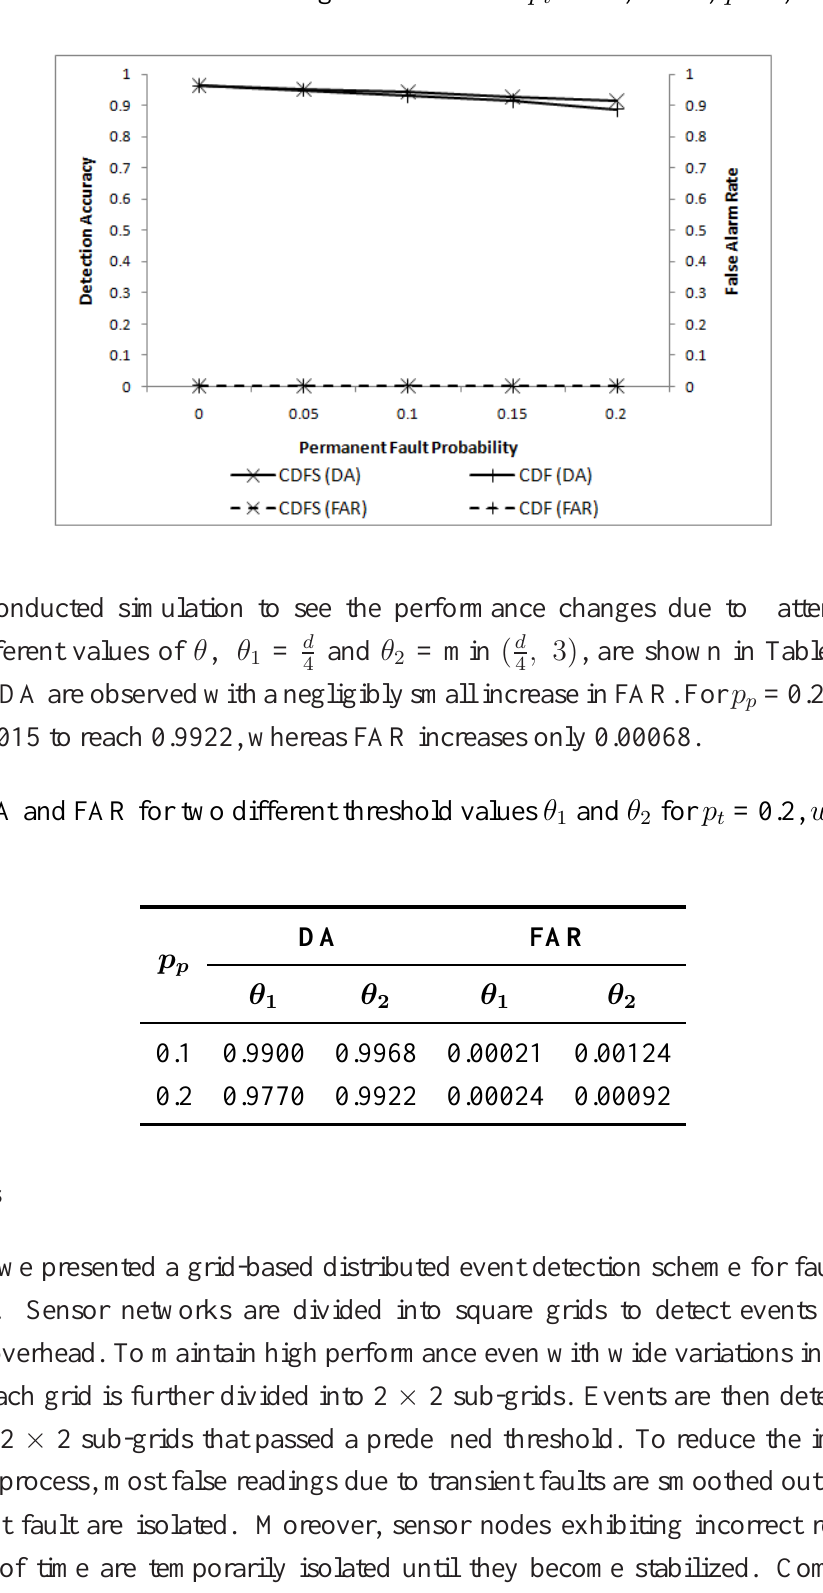
= 0.2, w = 4, q = 3, and l = 2.5 r . t